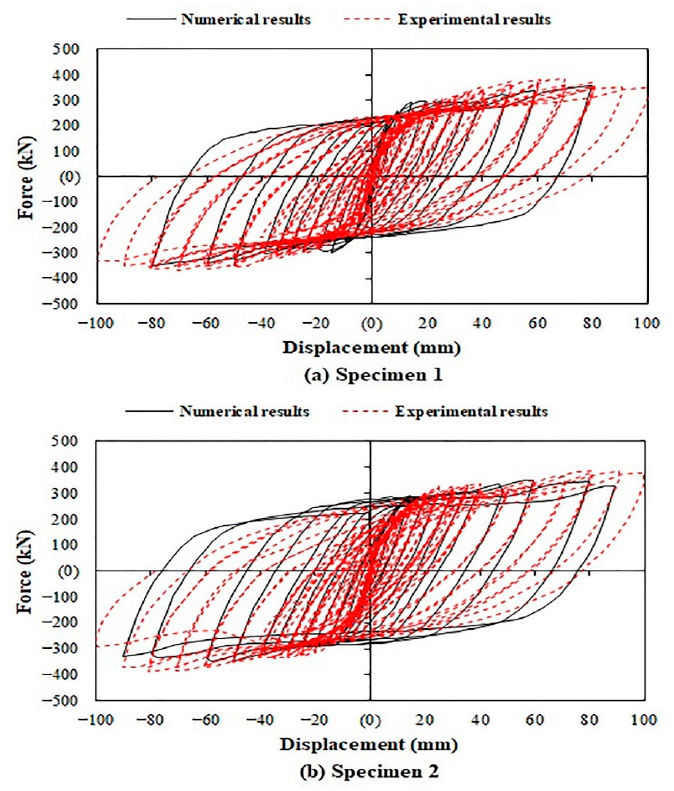
Figure 20. Hysteretic behavior of tested specimens.